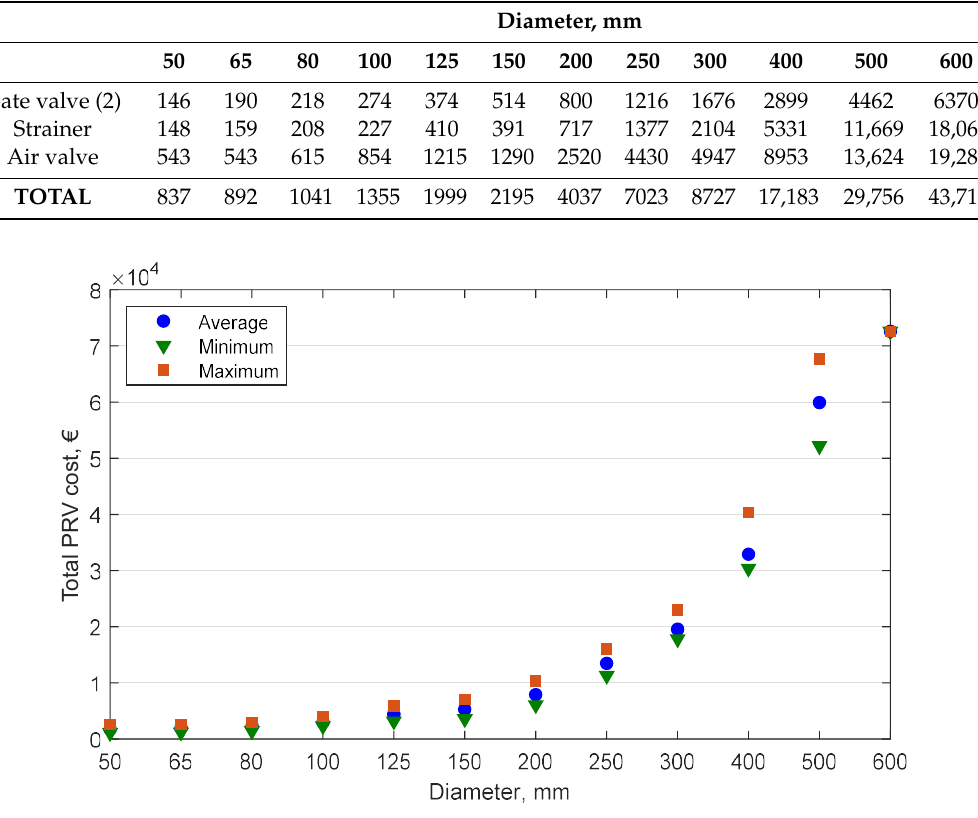
Figure 7. Total PRV cost for diameters ranging from 50 mm to 600 mm.